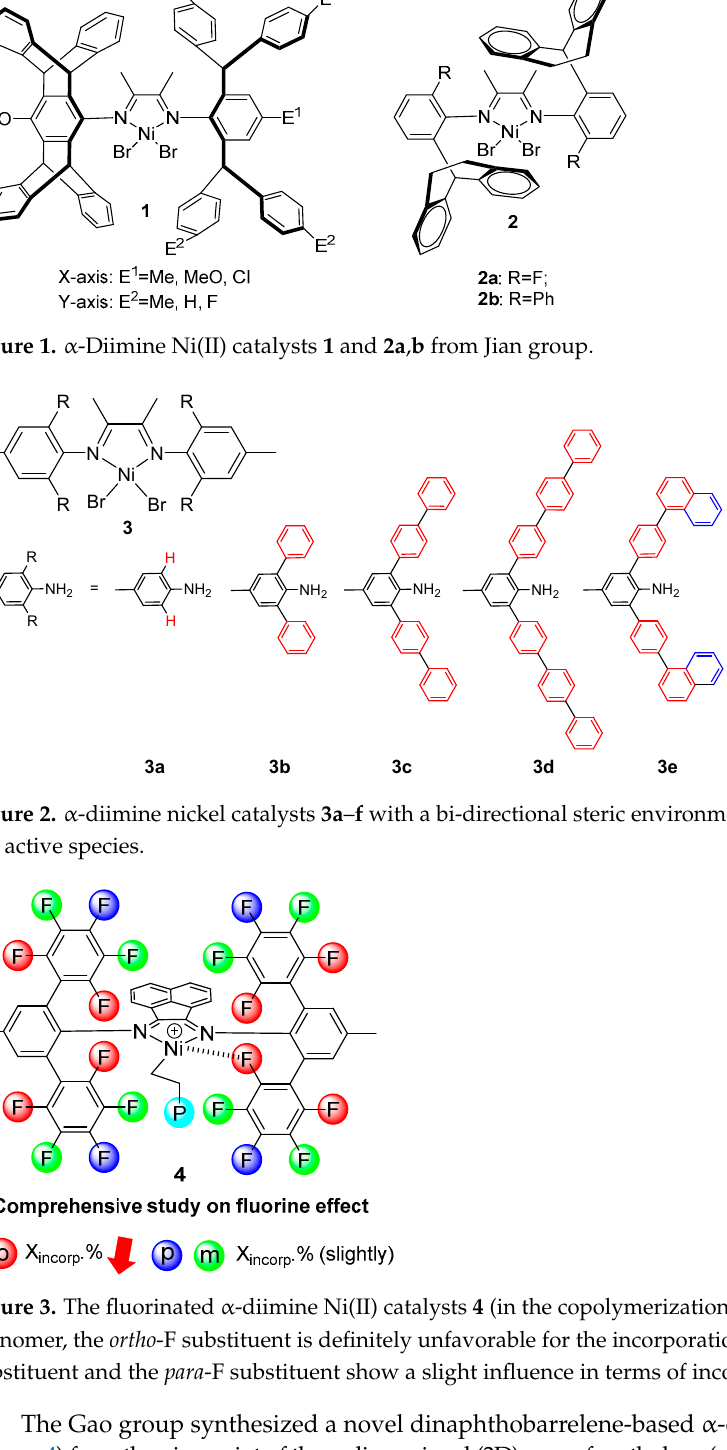
ymerization of ethylene and 10-undecenol (UOH) was still active to produced copolymer with high incorporation of 5.21 mol %, and the living copolymerization could also be re- alized below 35 °C, which was one of the rare samples for living copolymerization of eth- ylene and polar monomers.